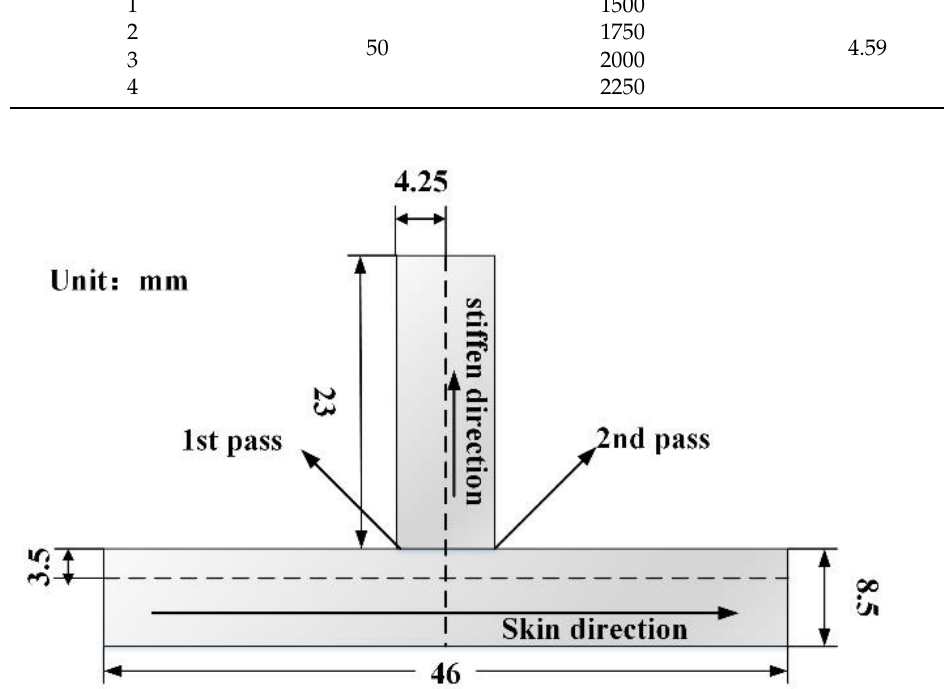
Figure 3. Illustration of the hardness test of SSFSW T-joint.